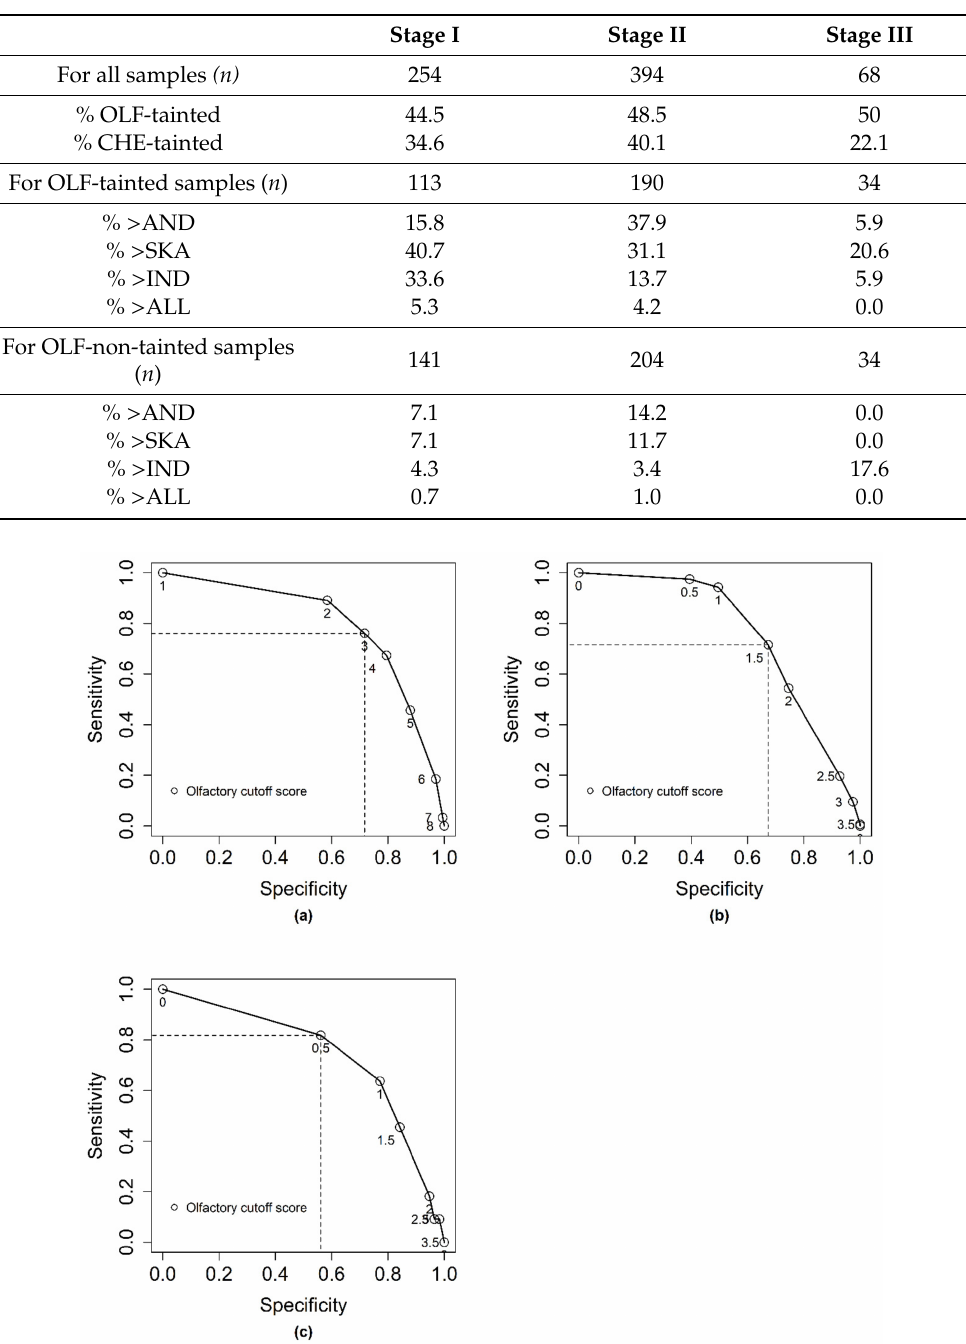
Table 2. Summary of subsample of chemically and olfactory evaluated samples from three stages of improvement of the scoring system. Chemical cuto ff s were 2.0 µ g / g for AND, 0.25 µ g / g for SKA, and 0.15 µ g / g for IND (CHE tainted).